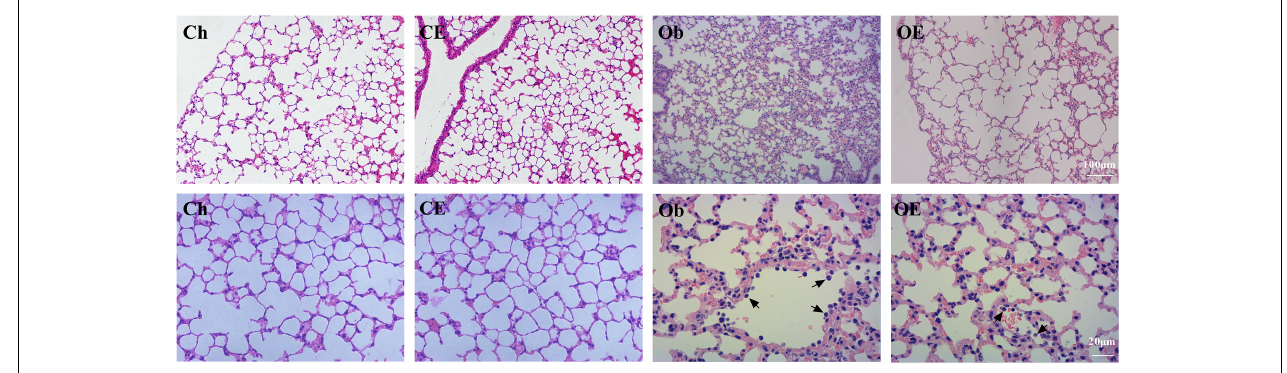
FIGURE 1 | Morphological analysis of lung tissue. Haematoxylin-eosin staining revealed evidence of the degree of inflammatory cell infiltration. Black arrows indicate neutrophils.